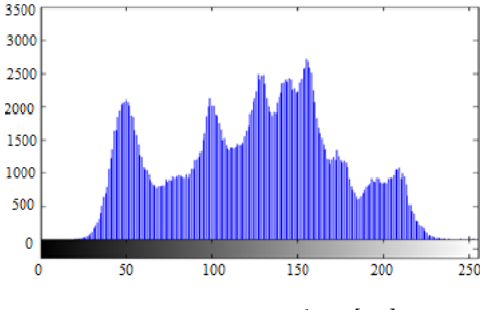
Figure 12: Approach in [18]